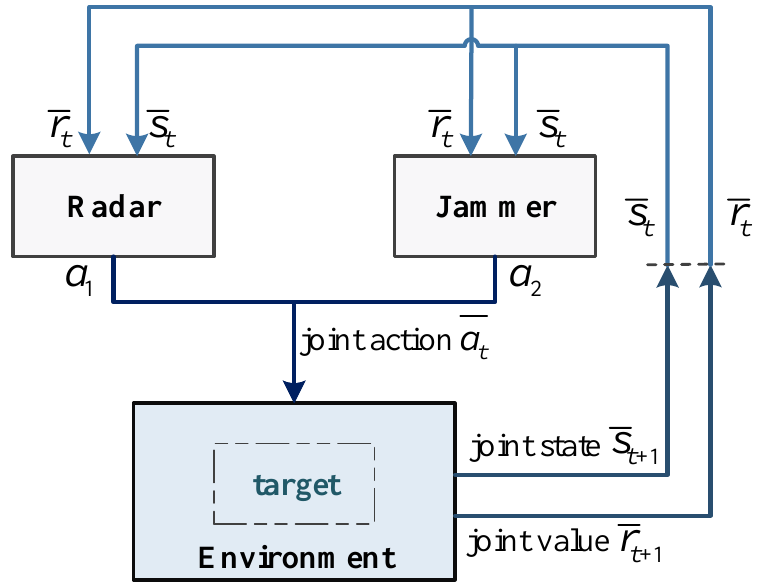
Figure 5. Environment model of radar system based on MARL.